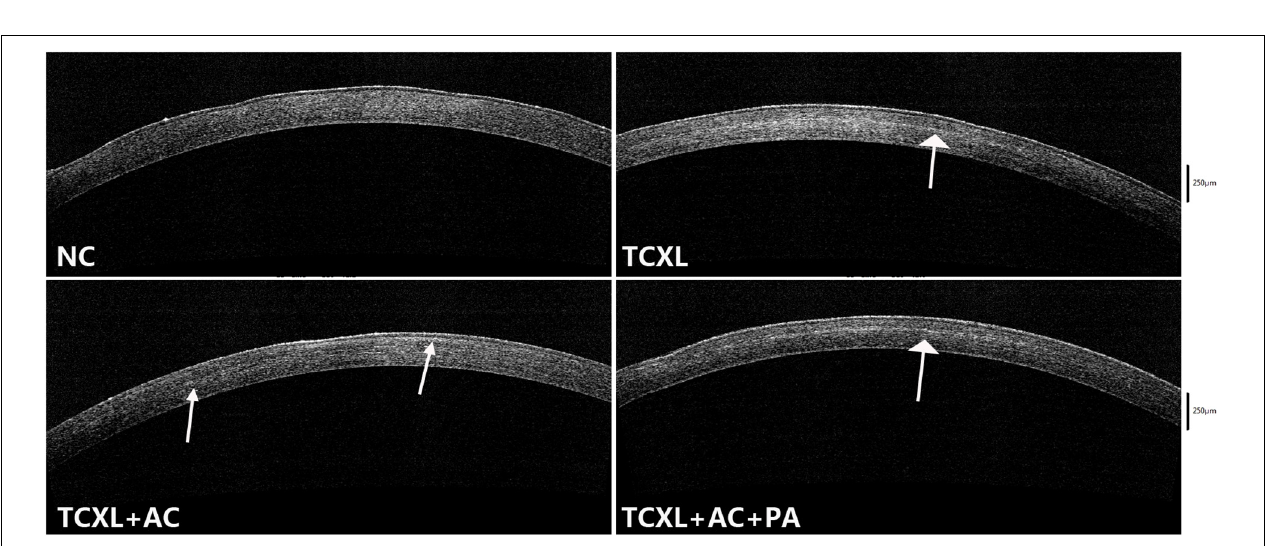
FIGURE 3 | Representative IVCM images showing collagen structures in the anterior corneal stroma on D28 at different depths (row A, 50–60 µ m; row B, 100–110 µ m; row C, 15–160 µ m; and row D, 200–210 µ m). At the depths of 150–160 µ m and 200–210 µ m, trabecular patterned hyperdense structure surrounded by elongated needle-like processes could be observed in the TCXL and TCXL + AC + PA groups (white arrows), but hardly seen in the TCXL + AC group.